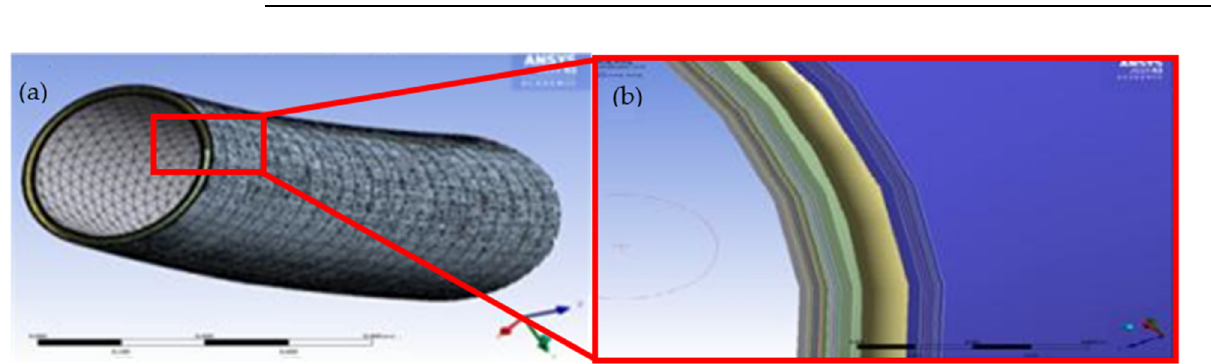
Figure 6. Mesh model of the marine hose in ANSYS Structural R2019, showing ( a ) the full hose model and ( b ) its close-up section view with details of layers and helix reinforcement . Table 4. Mesh statistics on the element/node count for the simplified model.